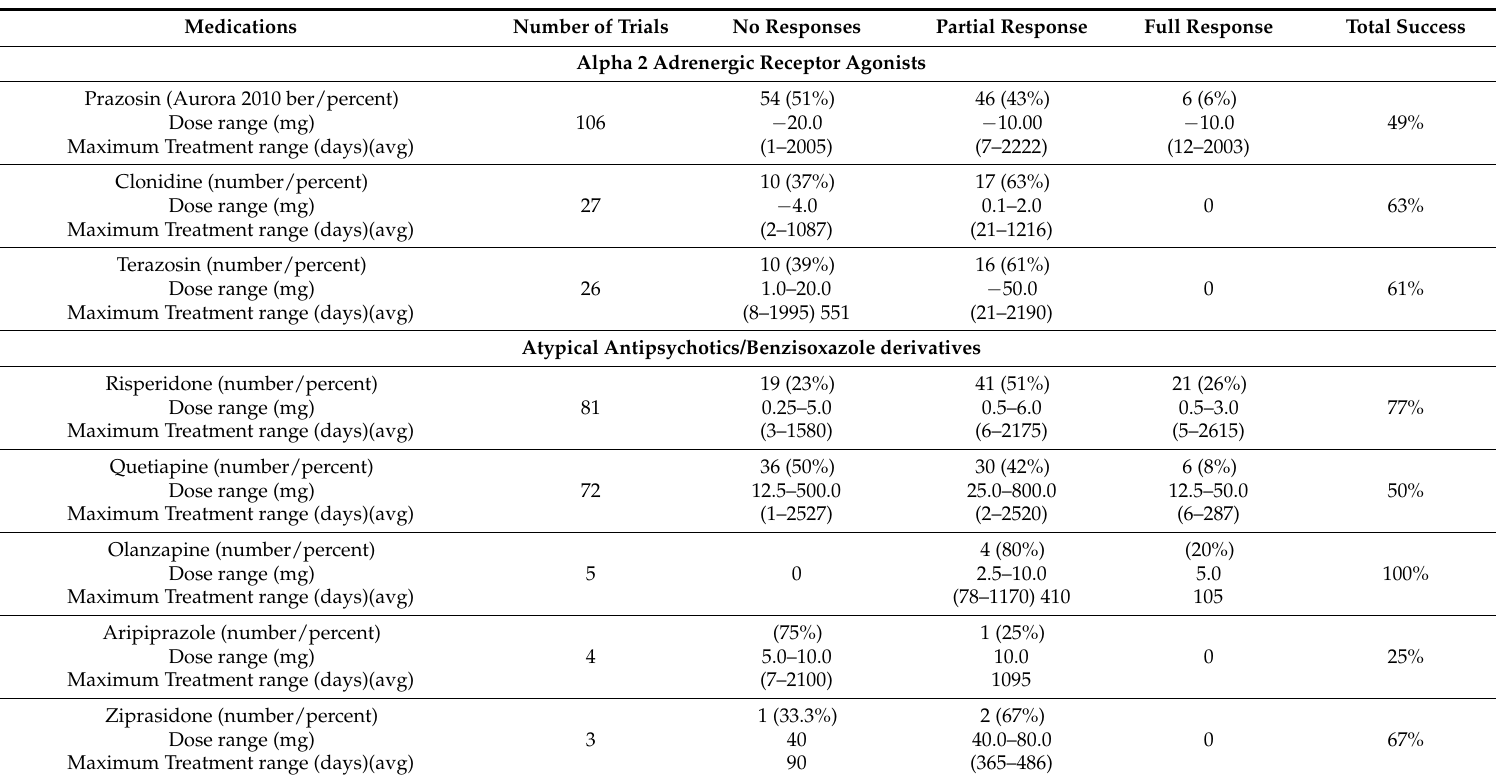
Table 1. Single and combinations of medications utilized to treat combat